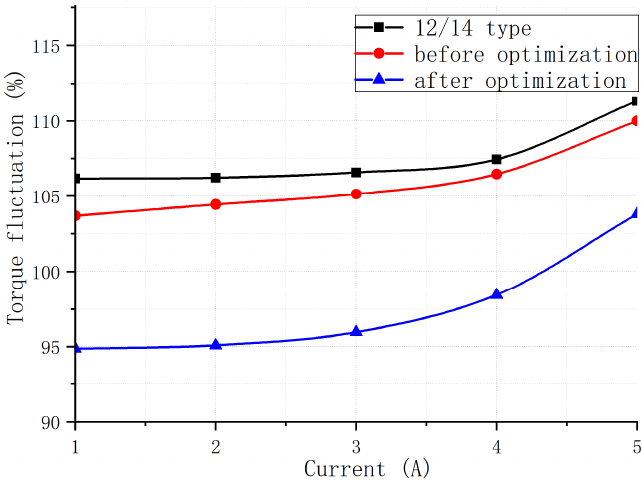
Figure 19. Comparison of torque fluctuations of three motor structures.